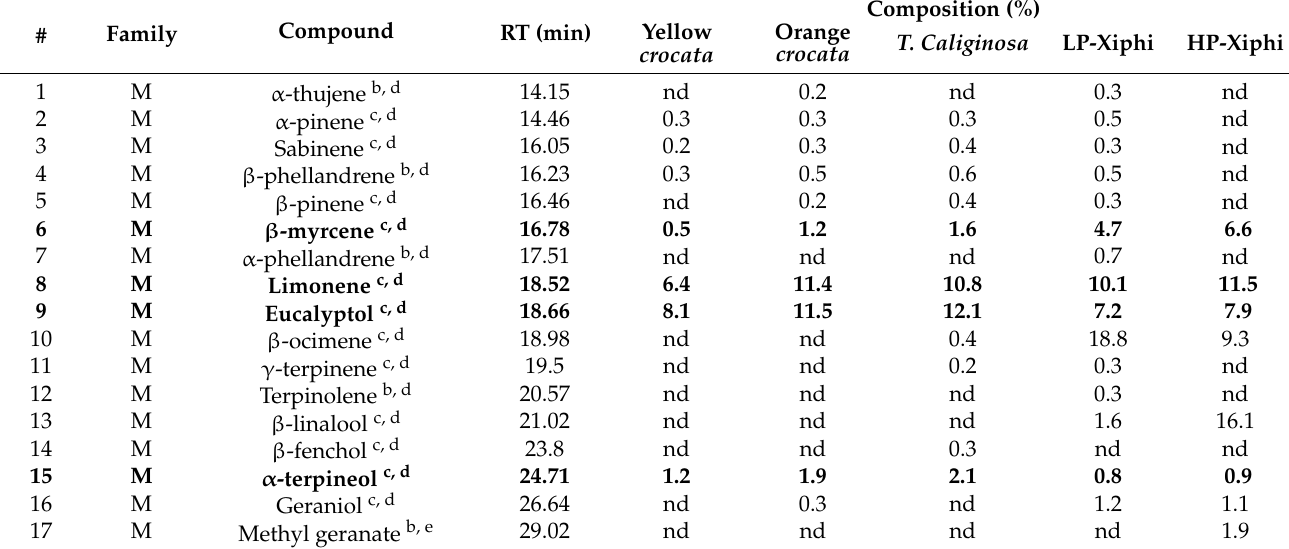
Table 2. Identification of volatile compounds from floral emissions of T. xiphioides , T. crocata , and T. caliginosa .